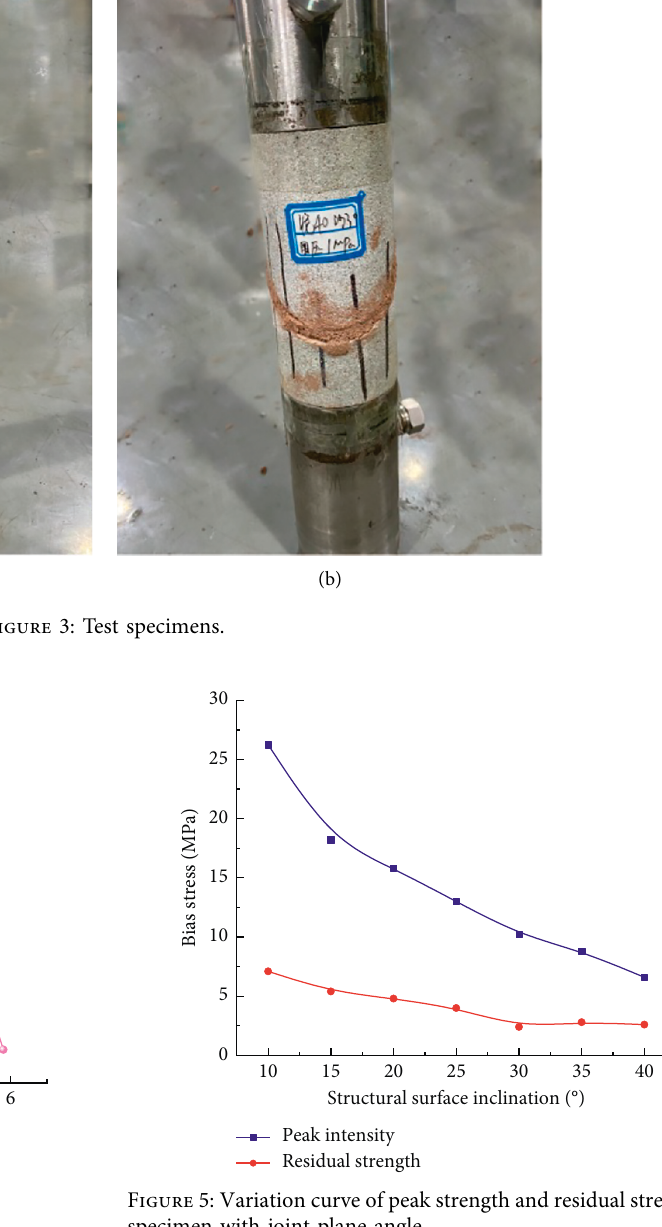
Figure 4: Stress evolution of mudstone specimens with different joint plane angles.